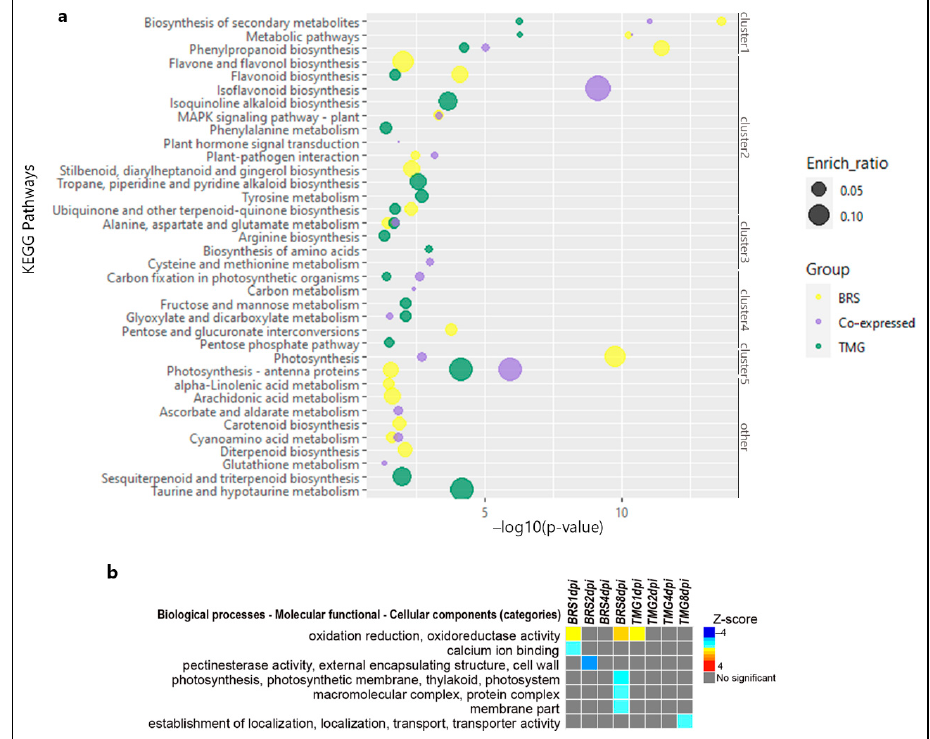
Figure 2. General KEGG pathways and GO enrichment of DEGs. Bubble plot of significant en- riched KEGG pathways in BRS, TMG, and co-expressed DEGs under RLN infection. The enrich- ratio is represented by the size of each bubble as the pathway enrichment level, as well as their level of significance based on − log10( p-value ) in the x-axis ( a ). PAGE results showing up- or down-regu- lated gene ontology categories in soybean moderately resistant and susceptible genotypes during the four time-points of RLN infection. The statistical significance is inferred using a Z-score value. As a two-tailed test, the Z-score can be either positive or negative. Either the term has a positive Z- score and the fold-change mean of all associated genes is upregulated, or the term has a negative Z- score and the fold-change mean is downregulated [36] ( b ).